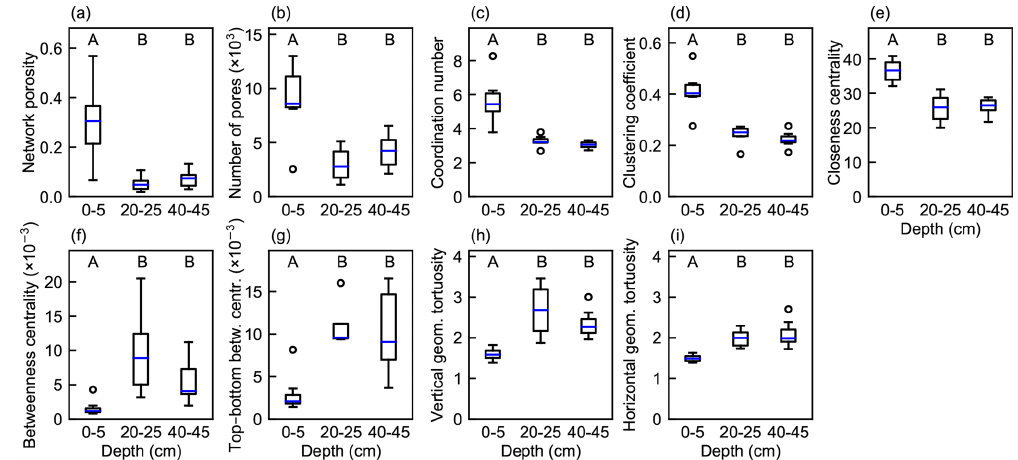
Figure 7. Boxplots of properties and metrics of pore networks generated from peat samples from different depths ( n = 4 for vertical geo- metrical tortuosity and top–bottom betweenness centrality at 20–25cm; otherwise n = 7). (a) Porosity of the pore networks; (b) number of pores in the networks; (c) network average coordination number; (d) network average clustering coefficient; (e) network average closeness centrality; (f) network average betweenness centrality; (g) average betweenness centrality for paths between top and bottom boundary pores; (h) average geometrical tortuosity of the network in the vertical direction; (i) average geometrical tortuosity of the network in the horizontal direction. Boxes indicate the interquartile range; whiskers extend at most to 1.5 times the interquartile range from the first and from the third quartile, and the blue line shows the median. Letters not shared across depths represent significantly different means via the pairwise com- parison tests ( p < 0 . 05). The Kruskal–Wallis test and Dunn’s post hoc test were used for the coordination number and clustering coefficient; otherwise ANOVA and Tukey’s post hoc test were applied. Table 2. Correlation coefficients between vertical geometrical tortuosity and different network connectivity metrics for pore networks at different depths. The coefficients are shown in italics if the relationship is not significant ( p > 0 . 05). Coordination Clustering Closeness Betweenness n number coefficient centrality centrality 0–5cm −